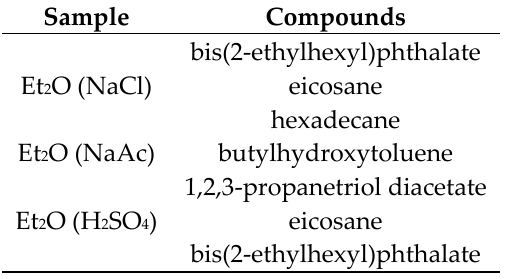
Table 2. Organic compounds extracted from cigarette butts by diethyl